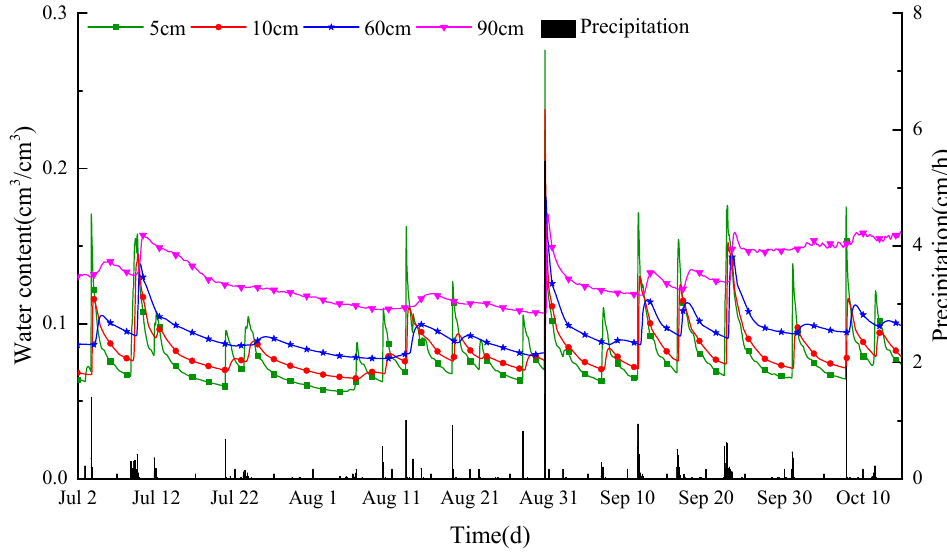
23 Table 3. Heat parameters obtained by the model after calibration. Layer